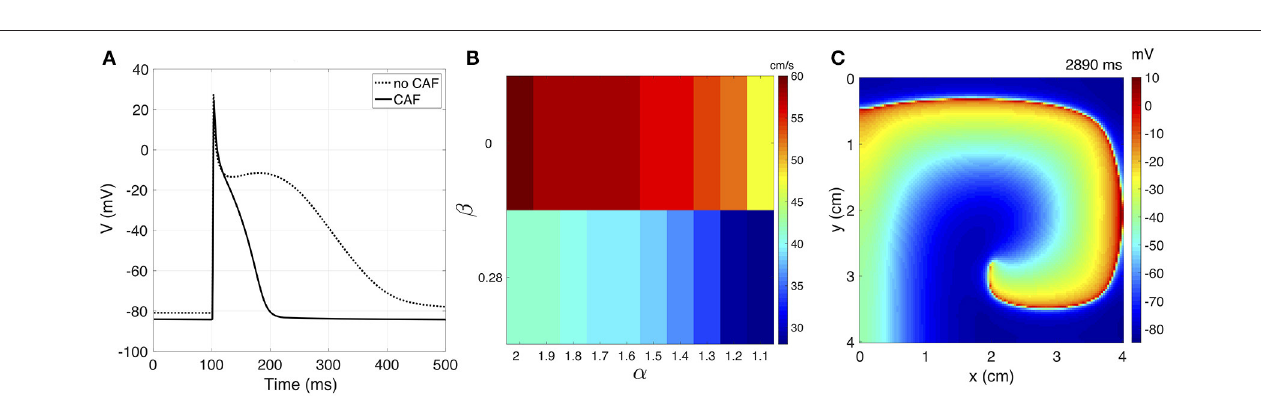
FIGURE 6 | (A) The unicellular AP curves for no CAF and CAF models. (B) CV map over the complex plane ( α , β ) under CAF conditions. (C) Sample frame of rotor propagation for γ = 1.6 + j 0.28.